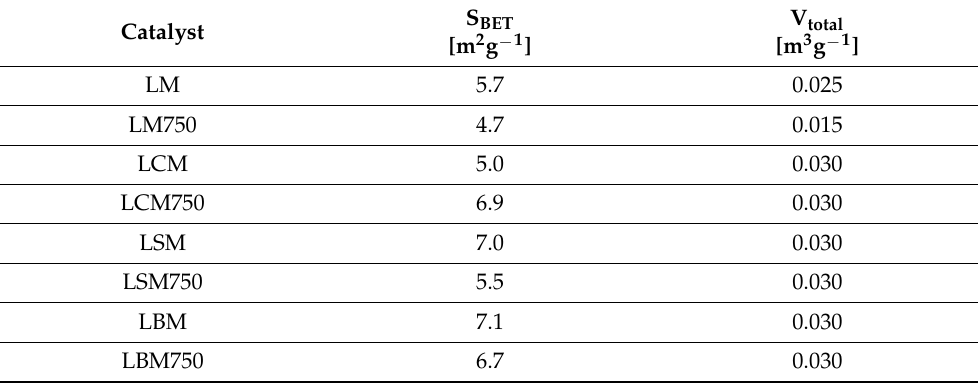
Figure 7. N 2 physisorption isotherms for LBM and LBM 750 samples. Table 3. Textural properties for as-prepared and calcined